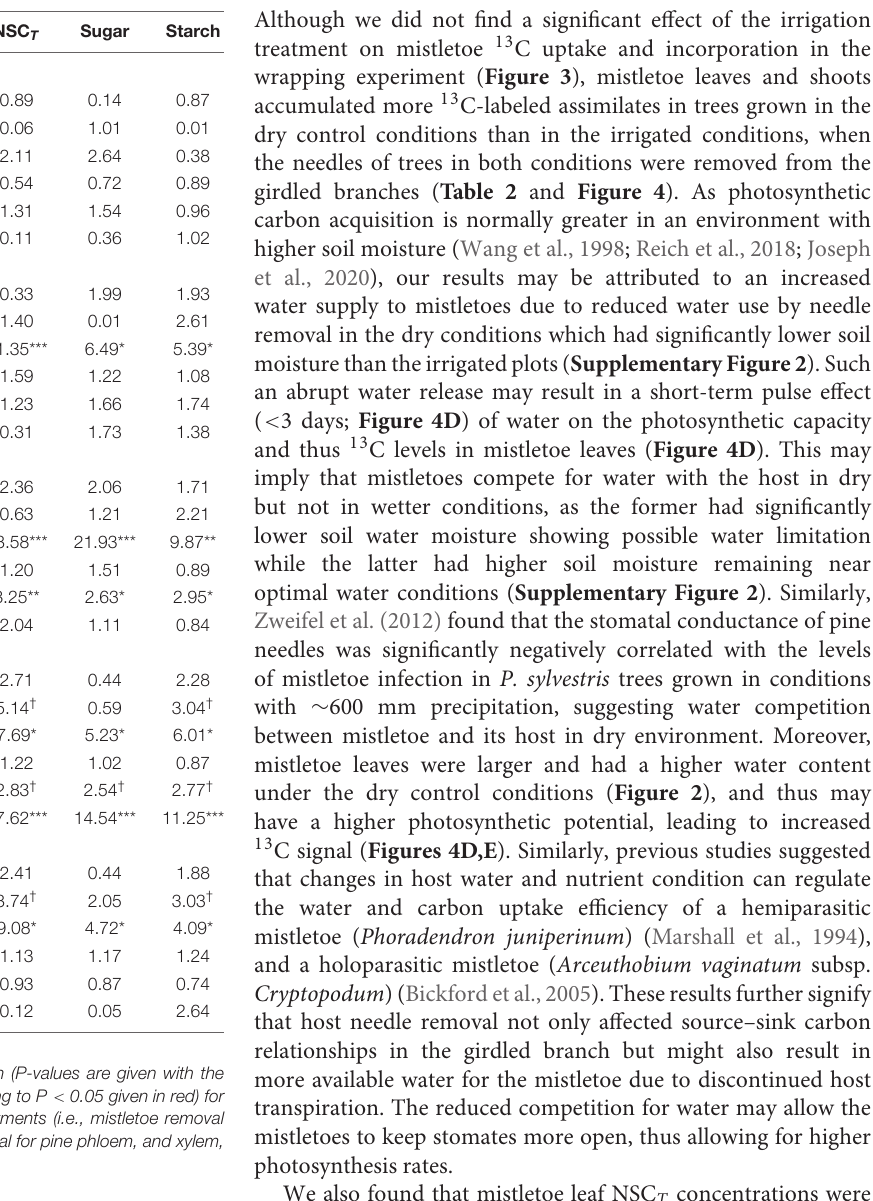
TABLE 2 | Results of linear mixed models for (cid:49) δ 13 C values (uptake and incorporation of 13 C) of bulk material, as well as the concentration of NSC T and its compounds (i.e., soluble sugars and starch) in different tissues of Pinus sylvestris and Viscum album ssp. austriacum in the removal experiment (Exp.